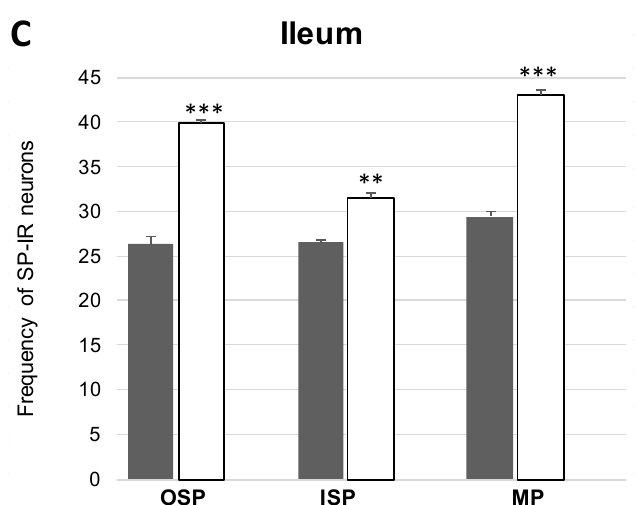
Figure 7. Colocalization of nNOS- positive cell bodies in the inner submucous plexus (ISP), outer submucous plexus (OSP) and myenteric plexus (MP) with substance P (SP) within the duodenum, jejunum and ileum in the control and experimental group. Mean (± SEM) percentage of neurons immunoreactive to nNOS and SP in the MP- myenteric plexus, OSP- intestinal outer submucous plexus, ISP- intestinal inner submucous plexus in the duodenum ( A ), jejunum ( B ) and ileum ( C ). Control (grey bars), experimental (white bars), ** p < 0.01, *** p < 0.001 – indicate differences between control and experimental